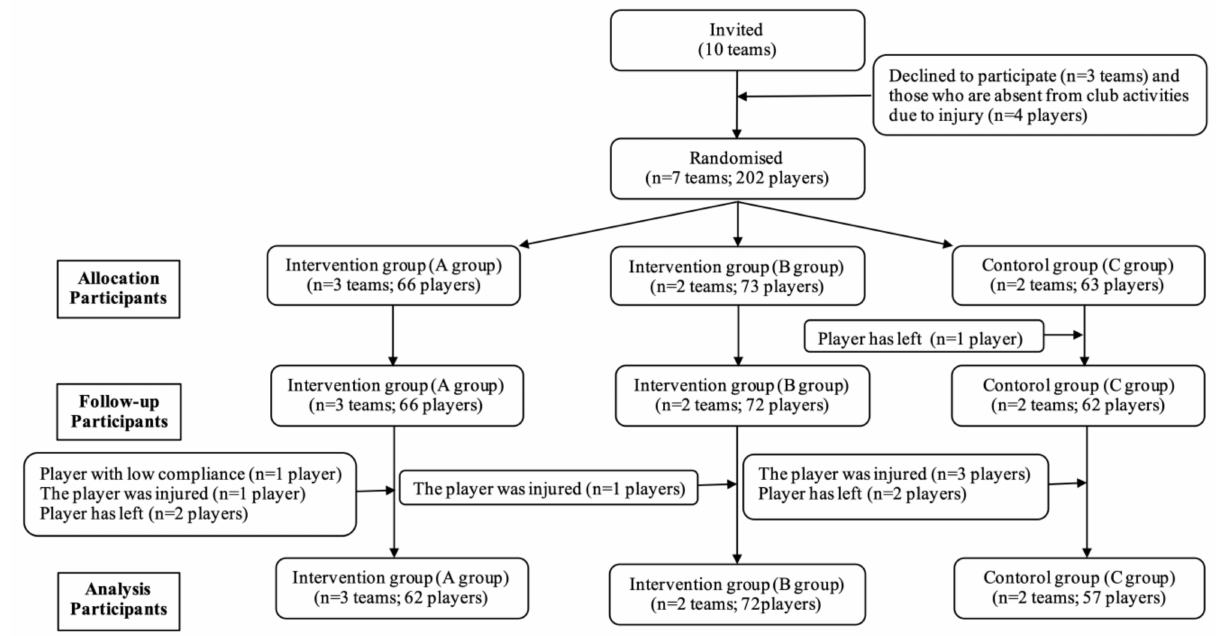
Figure 4. Flowchart showing numbers of players participating.